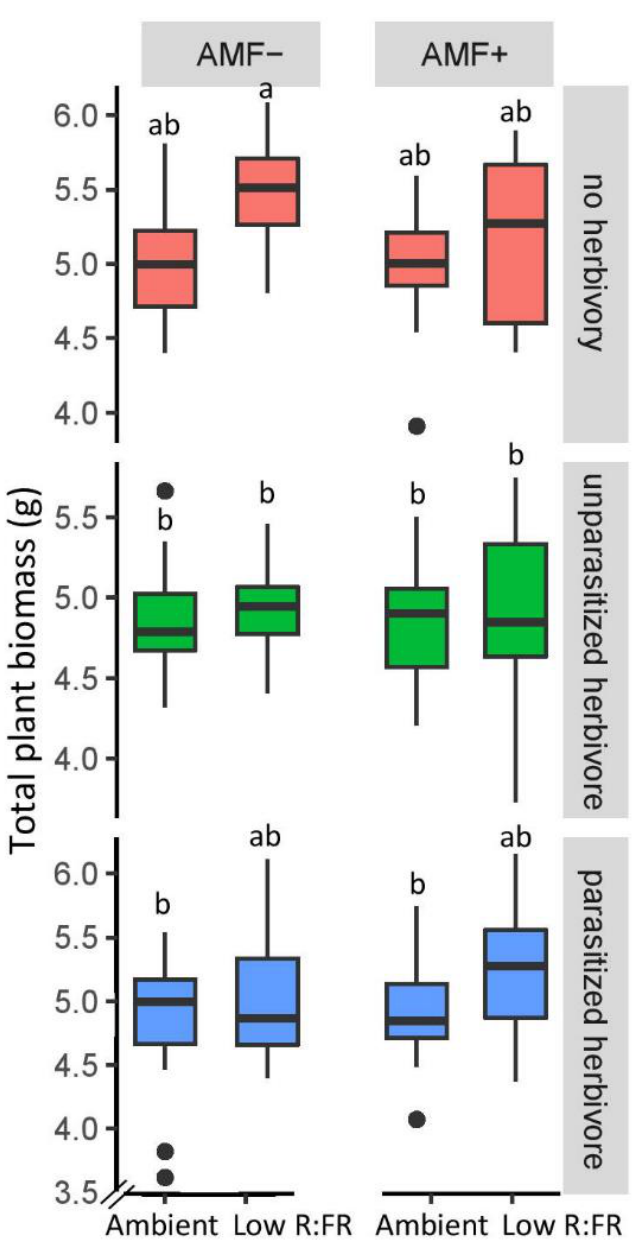
Figure 3. Total dry biomass of tomato plants grown under two light (Ambient, Low R:FR) and two inoculation treatments (AMF − : no mycorrhiza, AMF+: mycorrhiza) and subjected to three herbivory treatments. Boxplots that don’t share the same letter are significantly different p < 0.05 (Tukey HSD). The median is represented by the thick horizontal line; the box is defined by the 25th and 75th percentiles (lower and upper quartile). Table 2. General linear mixed models of the effects of light, microbial inoculation, and herbivory on dry weight production of different plants parts and on root mass fraction (RMF) at harvest. Total